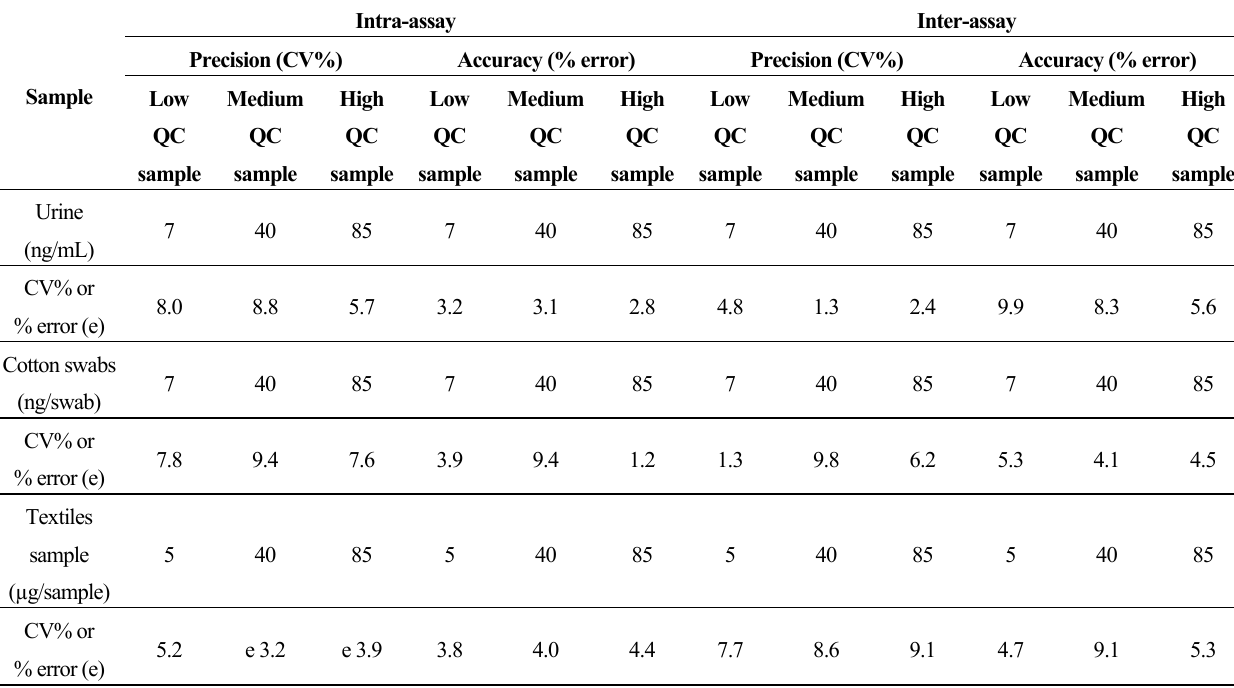
Table 2. Intra- ( n = 5 for each QC sample) and inter-assay ( n = 15) precision and accuracy for the analyte under investigation in quality control samples. QC, quality